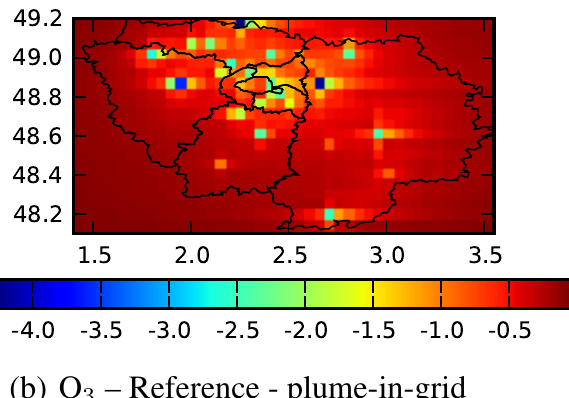
Fig. 7. NO 2 and O 3 concentrations over Paris region averaged over Fig. 7. NO and O concentrations over Paris region averaged over the simulation period, at ground level, 2 3 the simulation period, at ground level, in µgm − 3 . (a) shows the in µg m − 3 . (a) shows the differences between mean ground concentrations with and without subgrid differences between mean ground concentrations with and without subgrid treatment for NO 2 . (b) shows the differences between mean treatment for NO . (b) shows the differences between mean ground concentrations with and without 2 ground concentrations with and without plume-in-grid treatment for plume-in-grid treatment for O . O 3 3